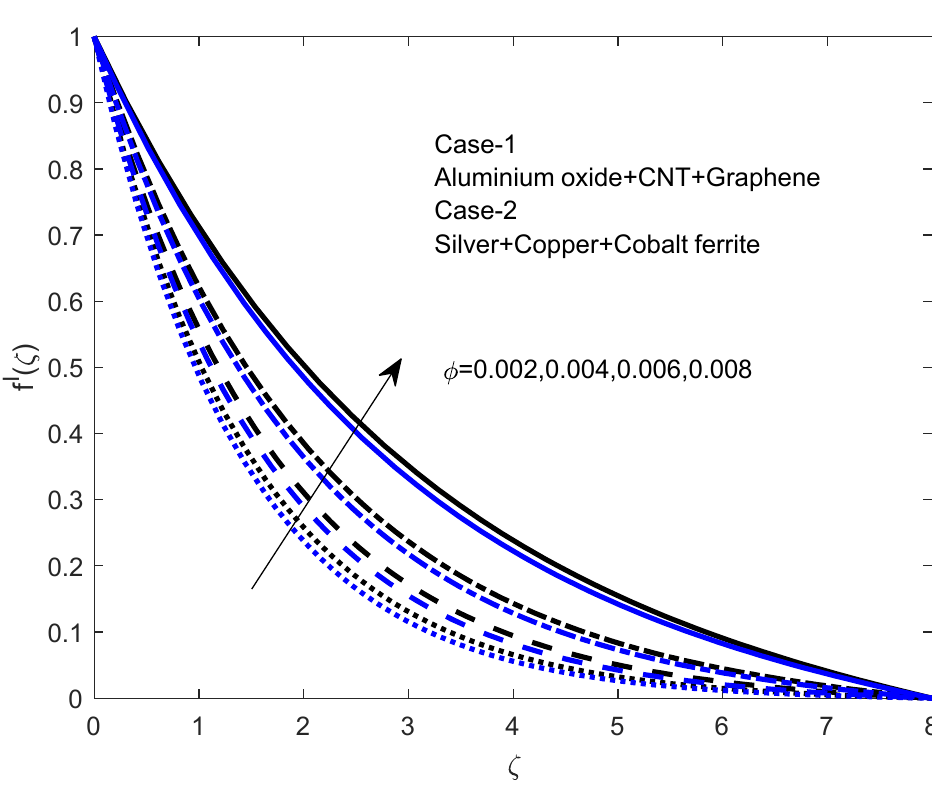
ϕ on the velocity profile. Figure 5. The effect ϕ on the velocity